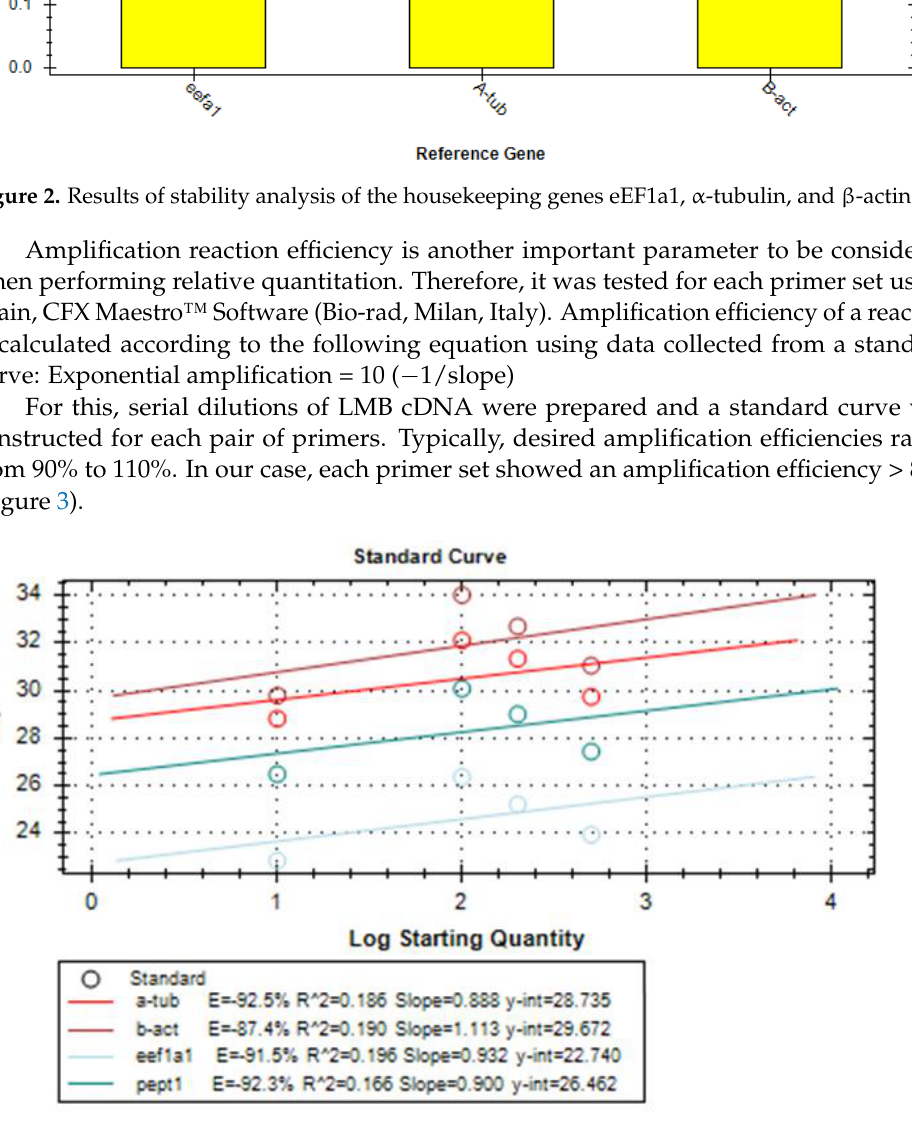
Figure 3. Results of amplification efficiency of each pair of primers for the target and housekeeping genes eEF1a1, α -tubulin, β -actin, and PepT1.